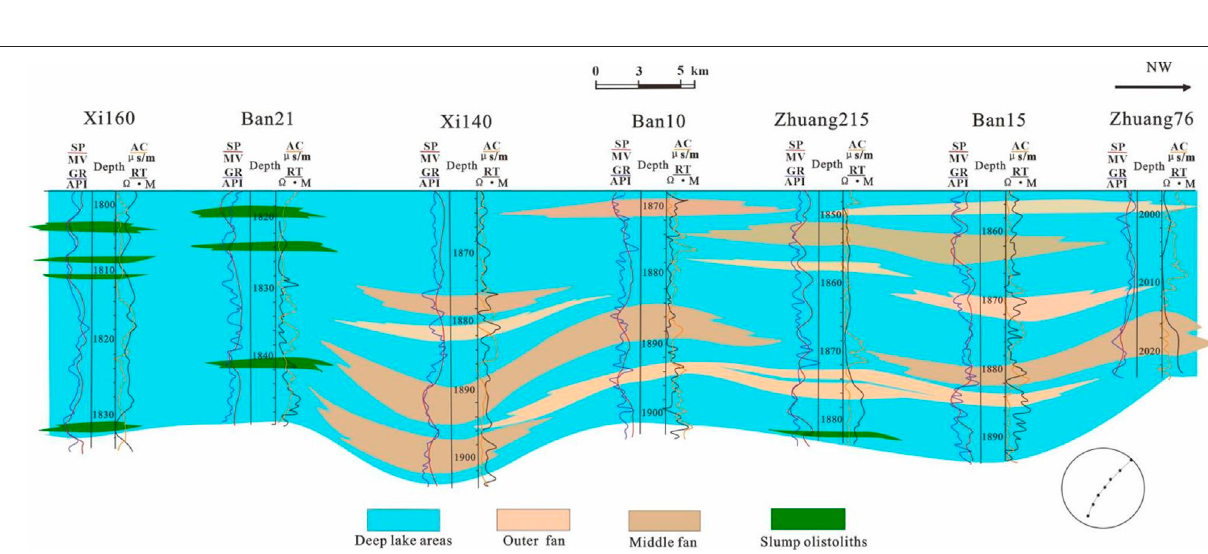
Frontiers in Earth Science |